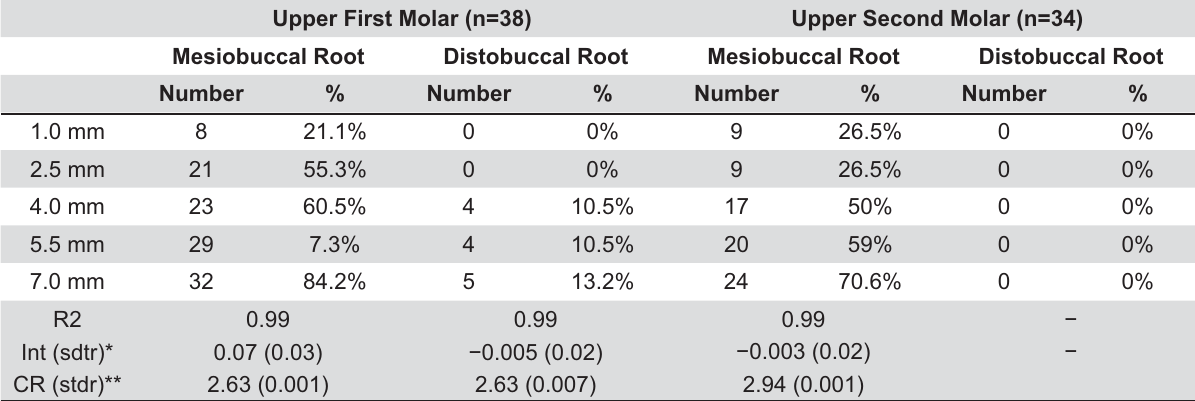
Table 4- Isthmus position along the root segments in lower molars